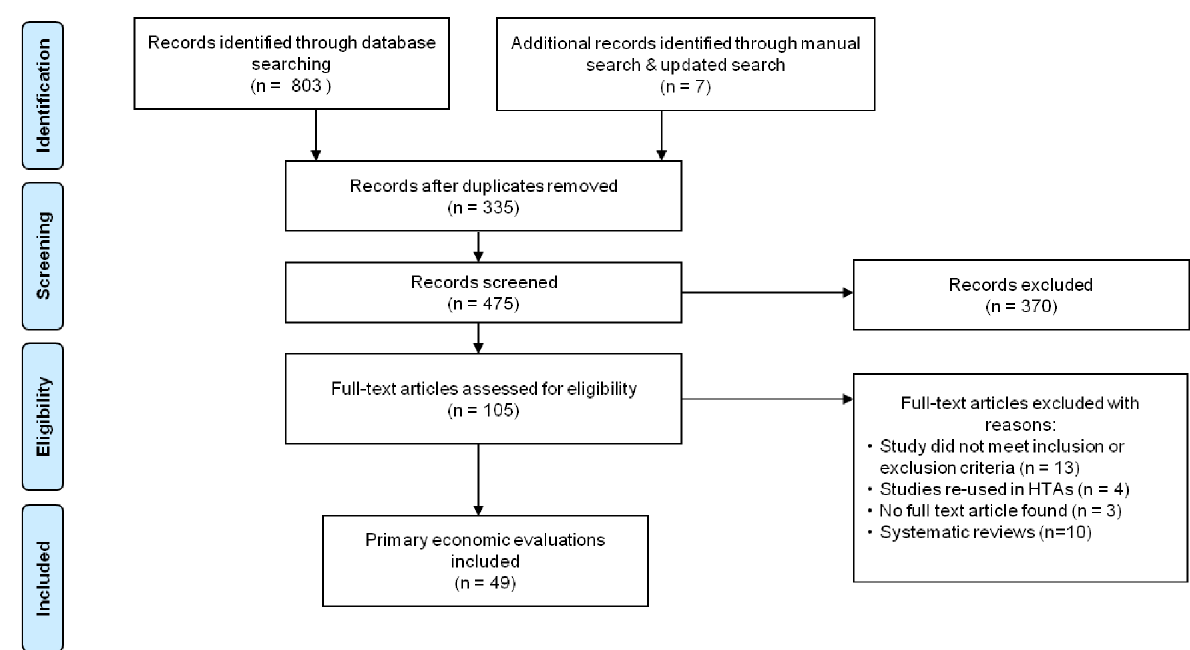
Fig 1. Flow chart of study inclusion based on the Preferred Reporting Items for Systematic Reviews and Meta-Analyses (PRISMA)[27].